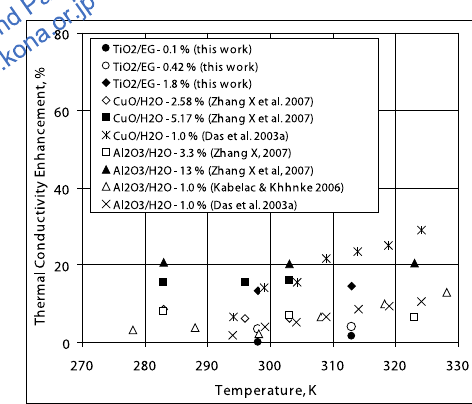
Fig. 3 Effect of base liquid property on thermal conductivity enhancement for alumina nanofluids: data taken from Lee et al. (1999), Eastman et al. (2001), Xie et al. (2002a), Das et al. (2003b) and Wen and Ding (2004b).